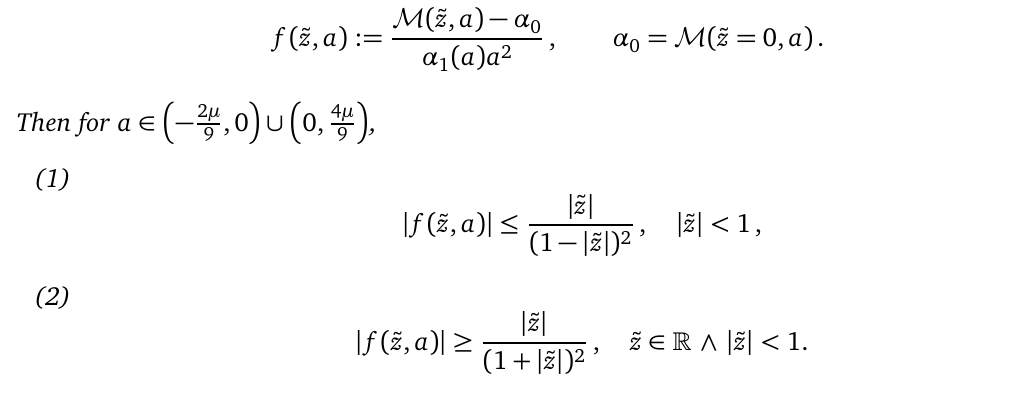
(cid:12) (cid:12) b 2 − 2 should be less than zero, W (cid:12) (cid:12) . Since 0,2 (cid:12) (cid:12) b 1